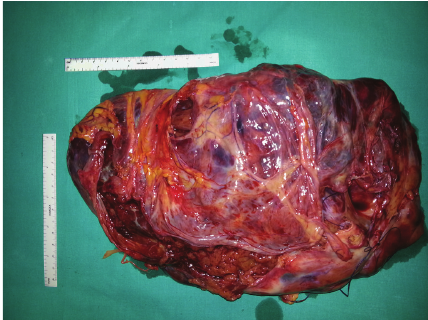
Figure 4: Surgical specimen: voluminous solid lesion measuring 26 cm at the greatest